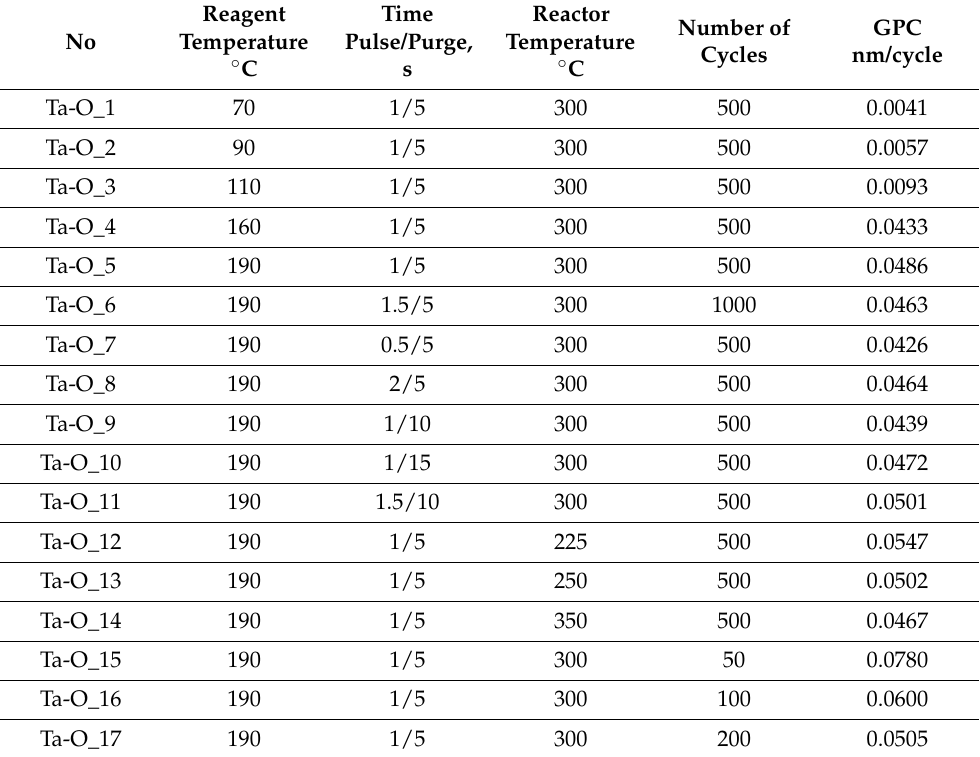
Table 2. Conditions of the ALD process for obtaining the Ta-O